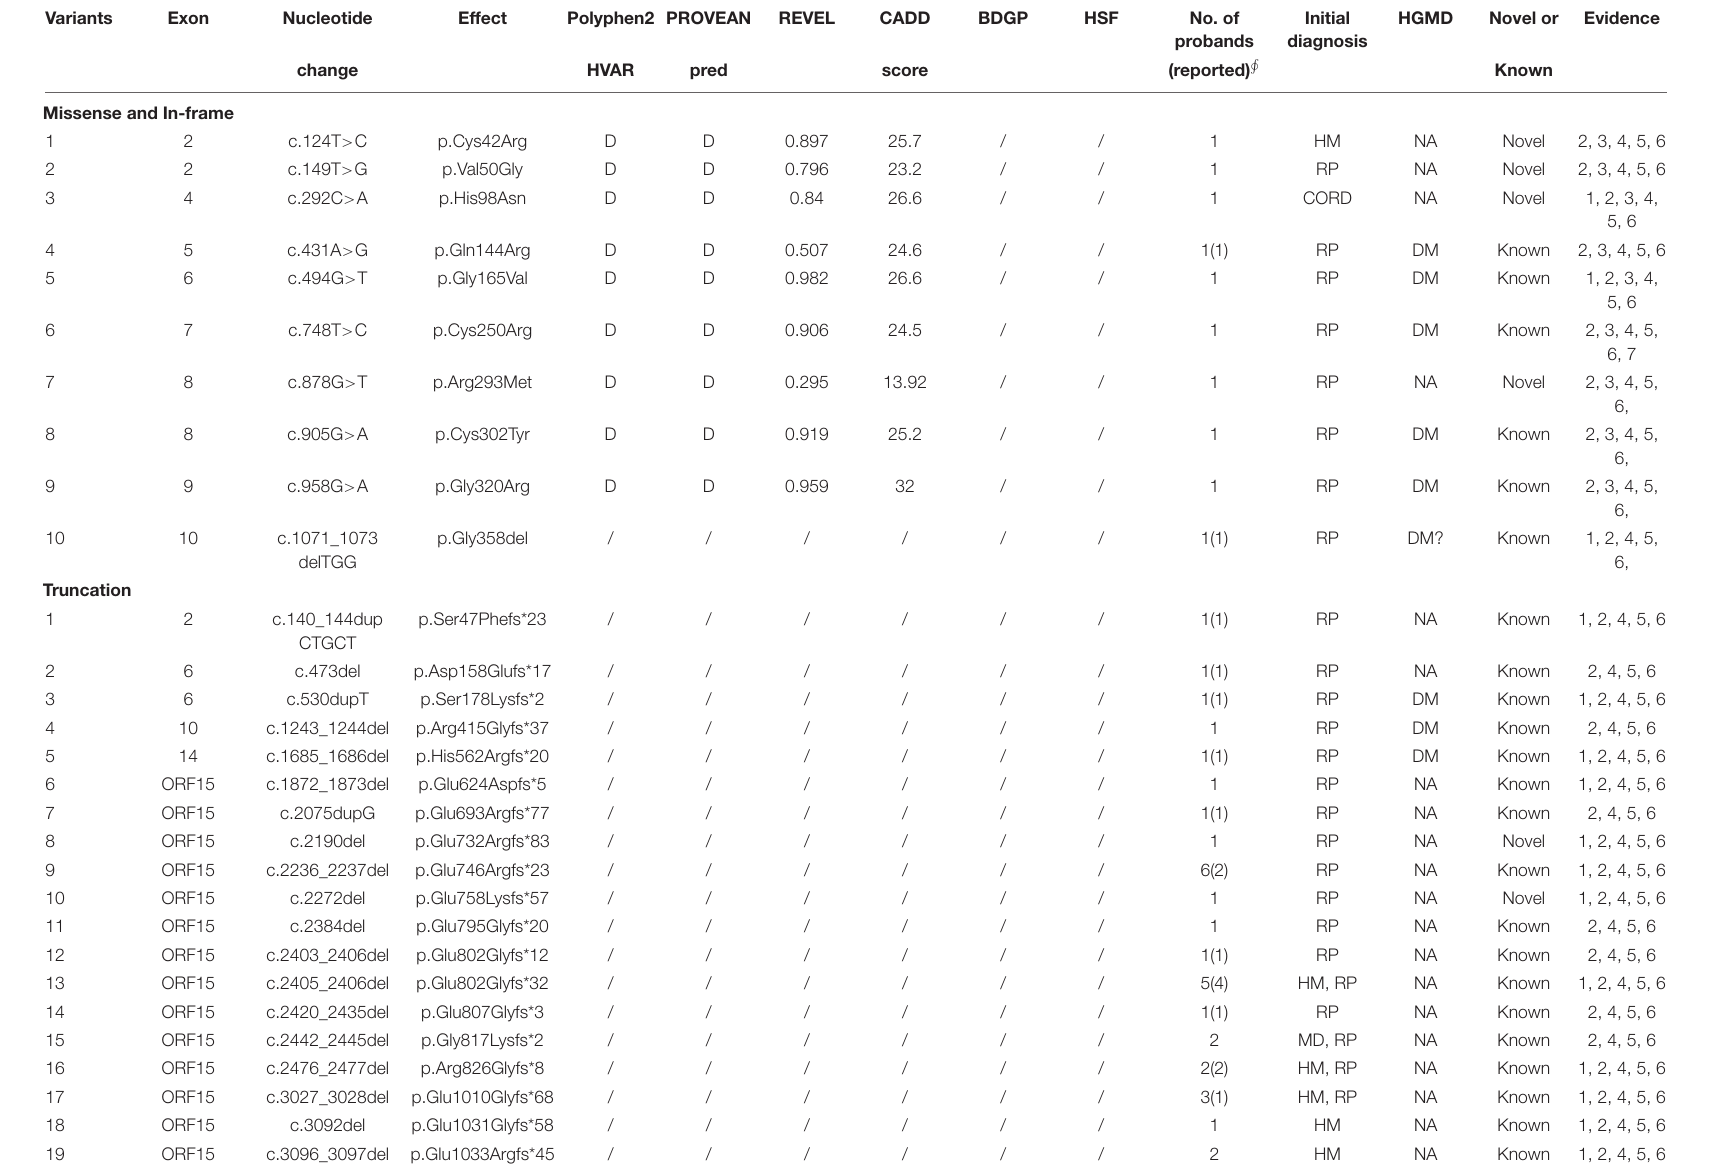
TABLE 1 | 46 likely pathogenic variants in RPGR from 62 unrelated families (based on